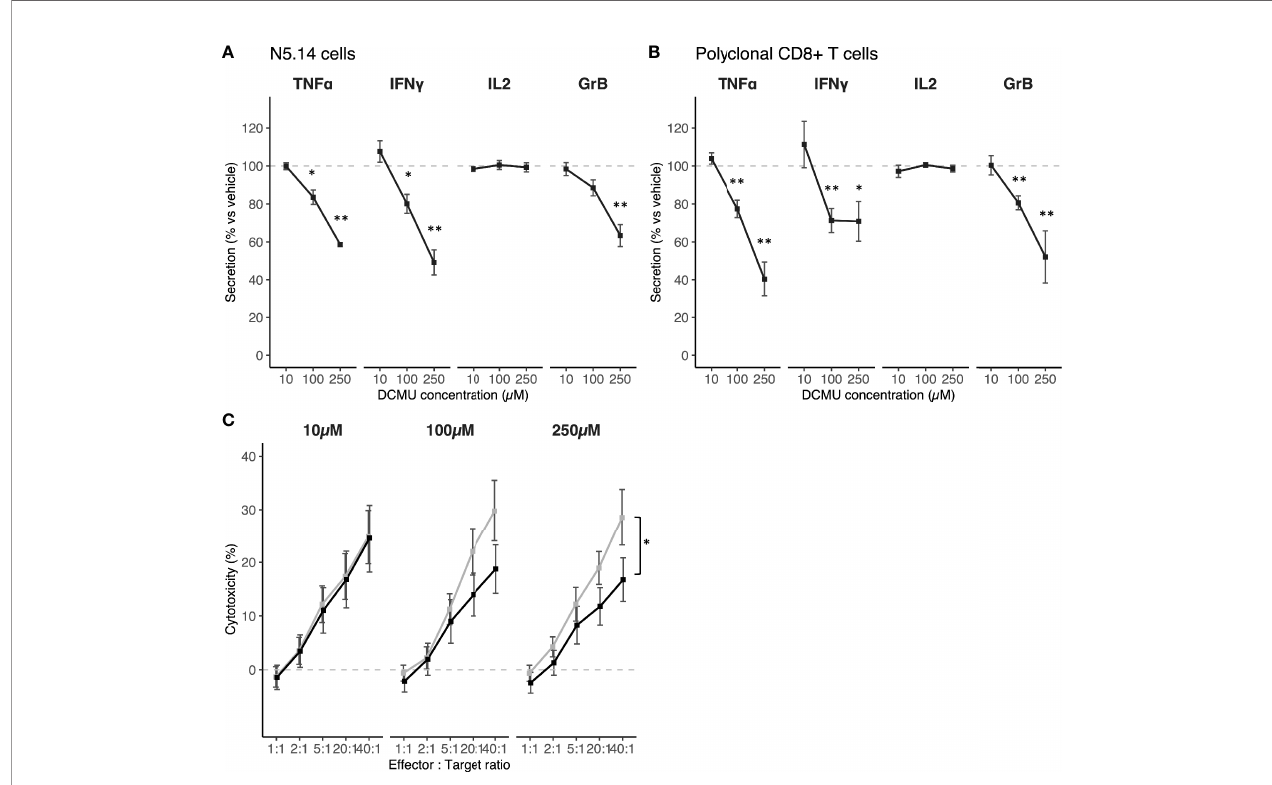
FIGURE 4 | Validation of the effect of DCMU exposures on different CD8+T cell populations. (A) TNF- a , IFN- g , IL-2 and Gr-B protein concentrations in supernatant of N5.14 cells exposed to DCMU during 24h. (B) TNF- a , IFN- g , IL-2 and Gr-B protein concentrations in supernatant of polyclonal CD8+ T cells exposed to DCMU during 24h. (C) Cytotoxicity assays against Meso34 cells by N5.14 cells. In black, N5.14 cells exposed to DCMU, in grey N5.14 cells exposed to vehicle only. Each time 3 independent experiments were run in triplicate per condition. Statistical signi fi cance: * p ≤ .05, ** p ≤